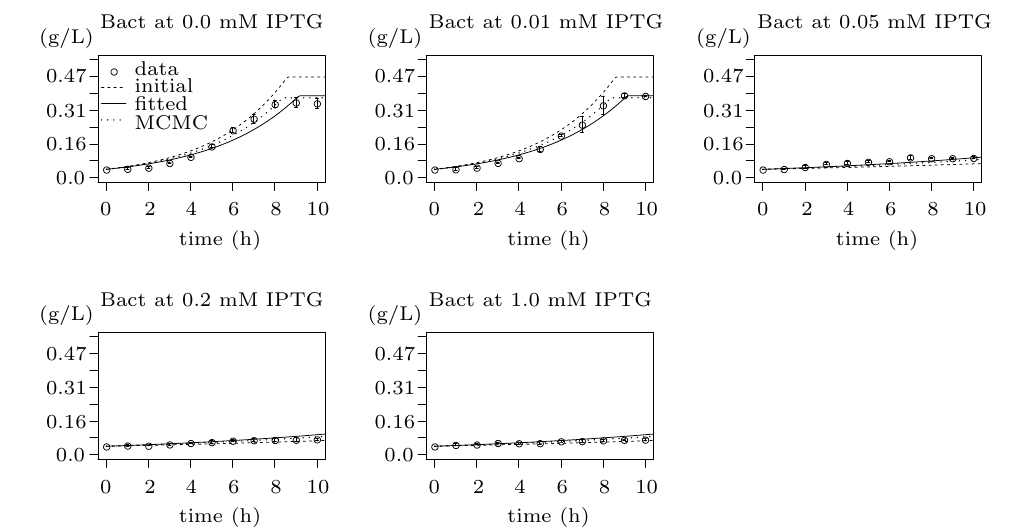
Figure 8. Results of fitting to population growth data reflecting metabolic burden caused by IPTG. The plot contains five figures, each showing fitting of the same model to the bacterial population growth data for different concentration of the inducer (IPTG) during 10 h long induction phase. The experimental data are pictured as points with standard error bars, the dashed lines show simulation data for initial values of the model function (i.e., initial point of fitting), the solid lines show the results of fitting and the dotted lines represent the final results optimised by MCMC method of the FME package (Section 2.6), which show the best agreement with the experimental data. The model with the best fit appears to be an enhanced Monod function where the maximum growth rate constant is substituted by the ramp function (defined in Figure 2) going from the maximum growth rate to the minimum growth rate reflecting the metabolic burden effect of the gradually-growing concentration of IPTG. The x-axes show the time of experiment in hours while the y-axes show CDW in g/L.